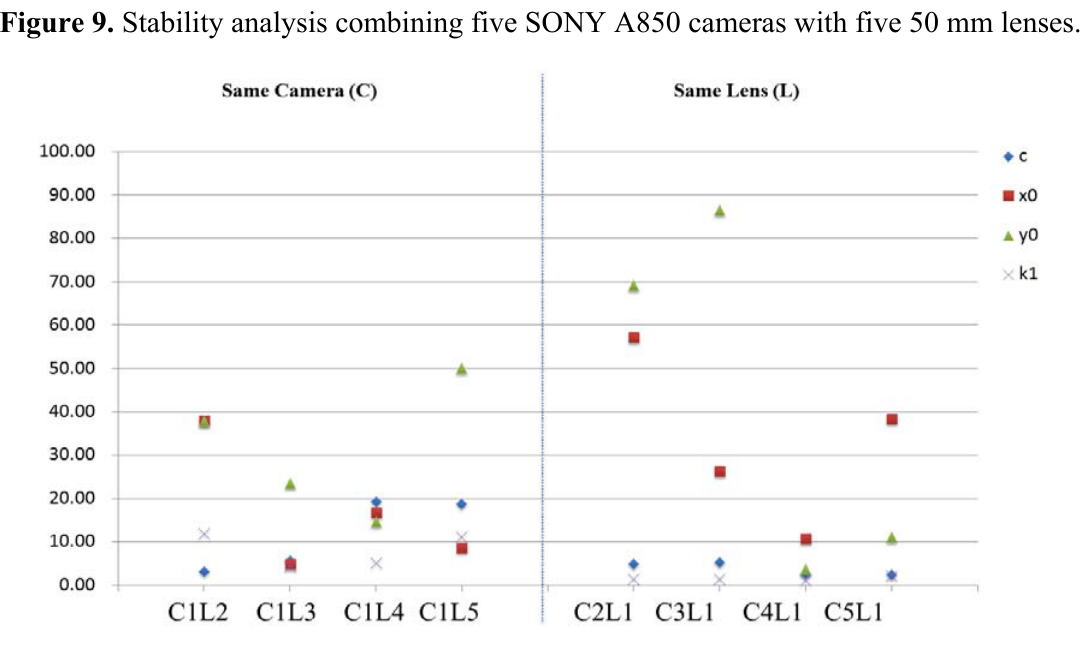
Figure 10. Stability analysis for a SONY A850 camera using a 50 mm lens in different